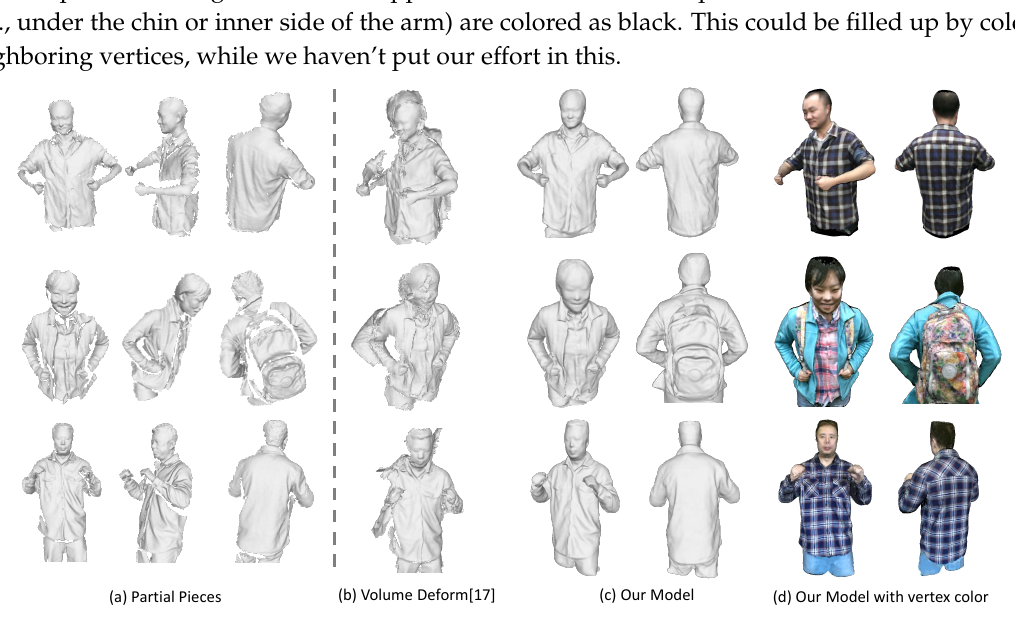
Figure 11. Qualitative evaluation on upper body models. ( a ) some sampled partial pieces; ( b ) the results from VolumeDeform [17]; ( c ) the complete models we get with our approach; ( d ) our recovered colored